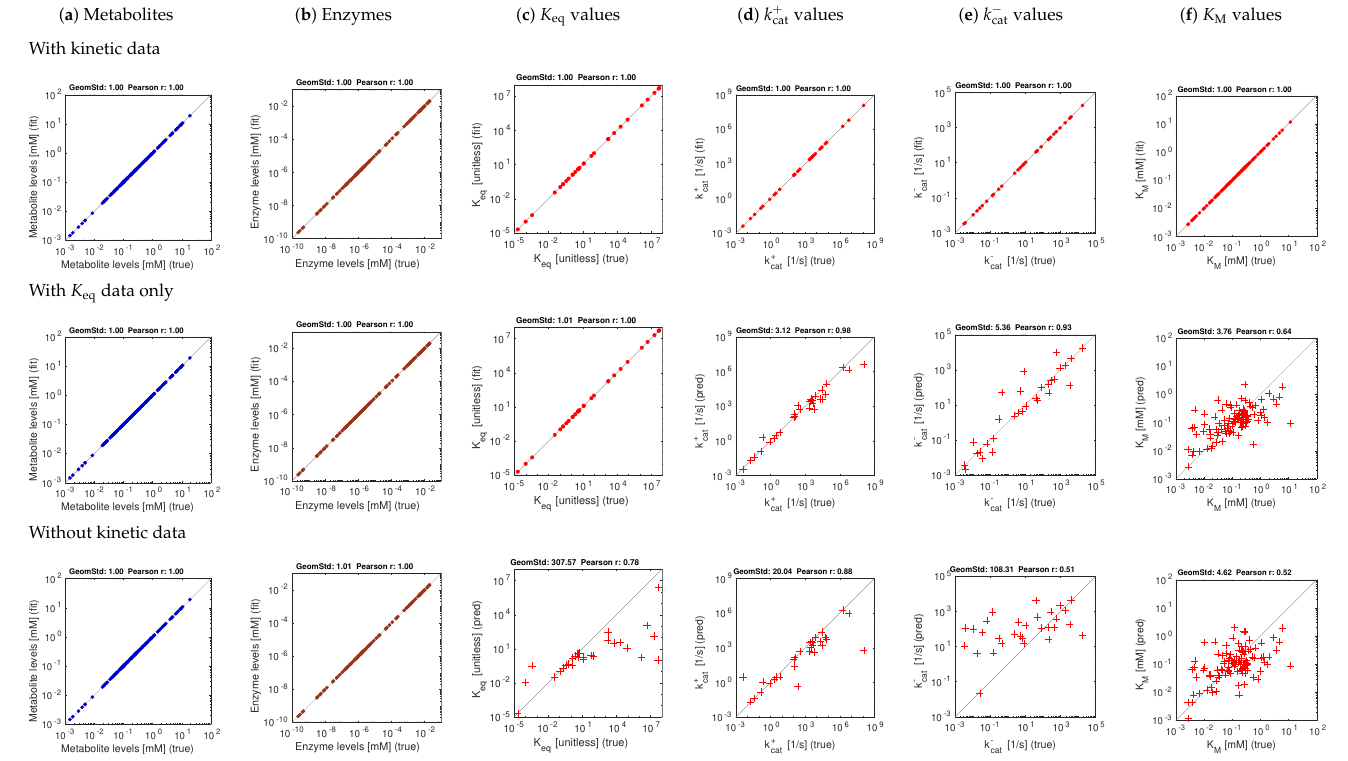
Figure 3. Model balancing results for E. coli model with artificial data (stringency parameter α = 0.5). The model structure is shown in [48]. Each subfigure shows “true” artificial values ( x -axis) versus reconstructed values ( y -axis). The quality of fits or predictions is quantified by geometric standard deviations and by Pearson correlations on logarithmic scale. ( a ) Metabolite concentrations; ( b ) enzyme concentrations; ( c – f ) equilibrium constants, k cat values, and Michaelis–Menten constants. The three rows show different estimation scenarios (see Supplementary Materials Figure S2). Upper row: simple scenario S1 (noise-free artificial data, data for all kinetic constants). Centre row: scenario S1K (noise-free artificial data, kinetic data given only for equilibrium constants). Lower row: scenario S2 (noise-free artificial data, no data for kinetic constants). Depending on the scenario, kinetic constants are either fitted (dots) or predicted